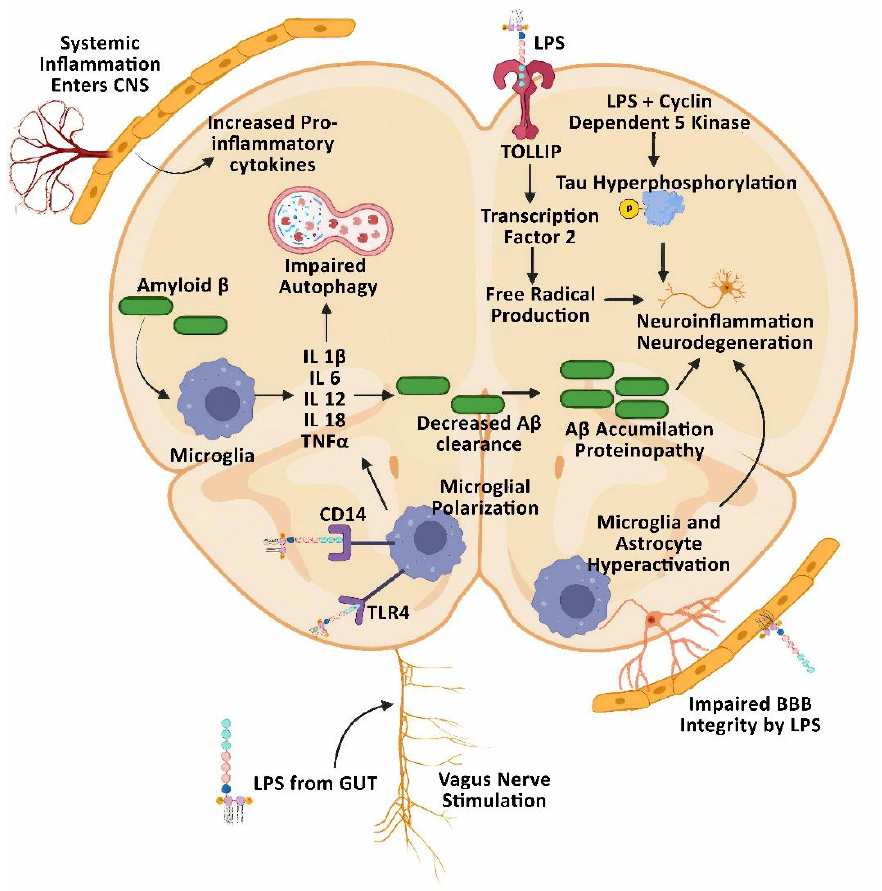
Figure 3. Lipopolysaccharide (LPS) induces neuroinflammation in Alzheimer’s disease (AD) brains. LPS enters the brain through the vagal nerve and systemic circulation and impairs the BBB further by binding to CD14 and TLR4 receptors. This causes microglial polarization, which further increases free radical stress, defective autophagy with elevated proteinopathy, and aggravated neuroinflammation accompanied by neuronal cell death in AD.